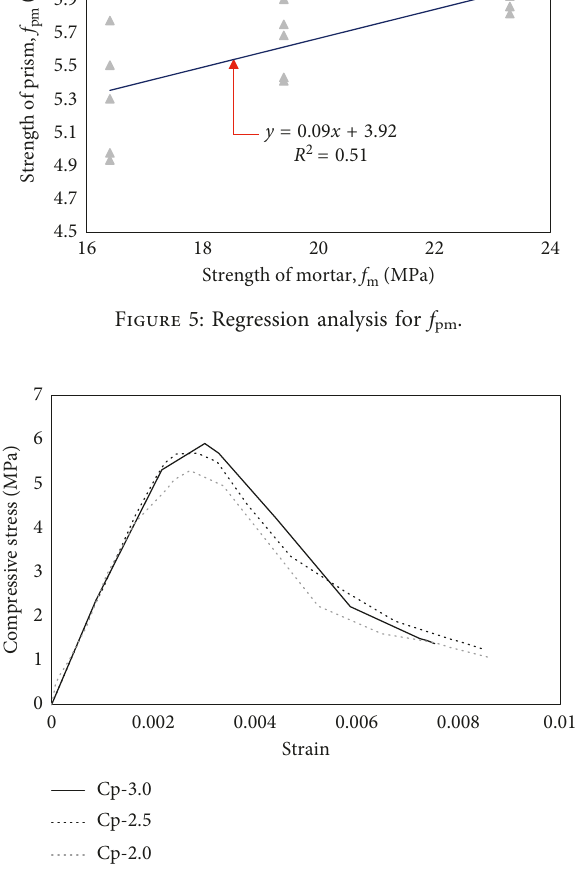
Figure 6: Compressive stress-strain curves measured in the concrete brick